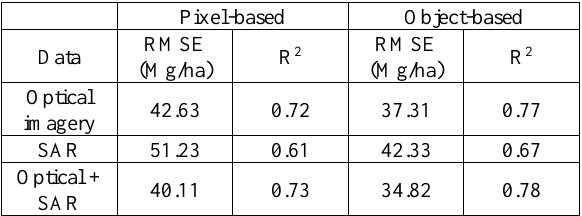
Table 1 . Comparison of pixel-based and object-based AGB estimation in HWF and PDF forests using the RF model for optical, SAR, and optical + SAR data.